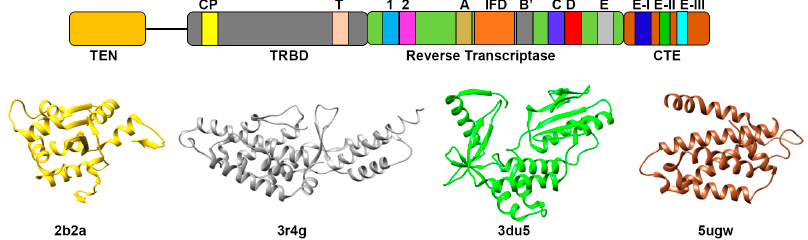
Figure 1. Schematic representation of TERT protein. Upper panel represents four domains of TERT protein as TEN, TRBD, Reverse Transcriptase and CTE domains. Motifs essential for activity of TERT protein domains are also shown in different colors. TEN and TRBD domains are joined by a linker. Lower panel shows TERT domains folding derived from crystal structures: Ten domain (PDB ID: 2b2a) and TRBD domain (PDB ID: 3r4g) from Tetrahymena thermophila , RT domain (PDB ID: 3du5) from Tribolium castaneum and CTE/thumb domain (PDB ID: 5ugw) from